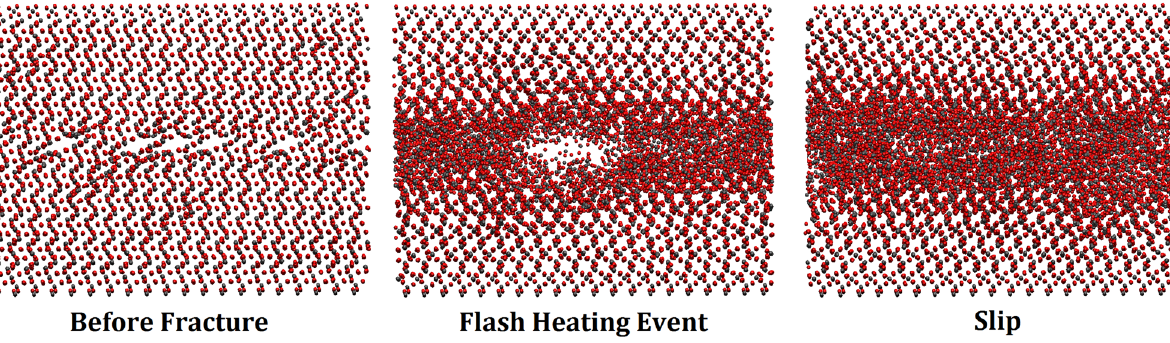
Figure 1. Dynamic evolution of Flash heating event for Structure A at a velocity of 0.3